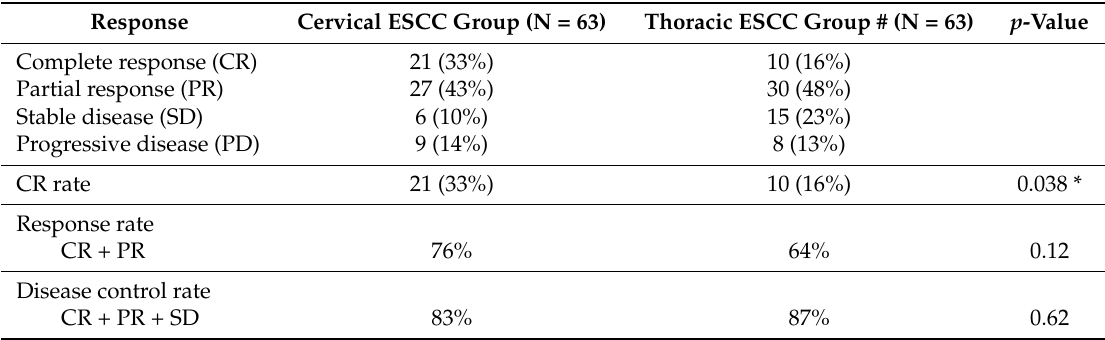
Table 3. Treatment response in 126 patients with locally advanced stage III cervical and thoracic esophageal squamous cell carcinoma who received curative concurrent chemoradiotherapy.